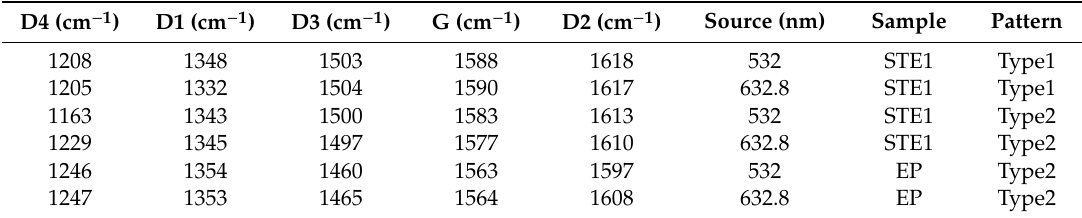
Table 2. Peak positions for STE1 and EP samples using 532 and 632.8 nm laser